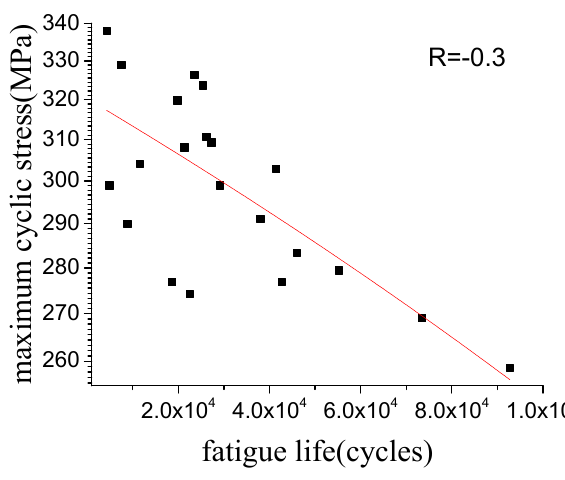
Figure 2. Fatigue curve of the FSW joint.